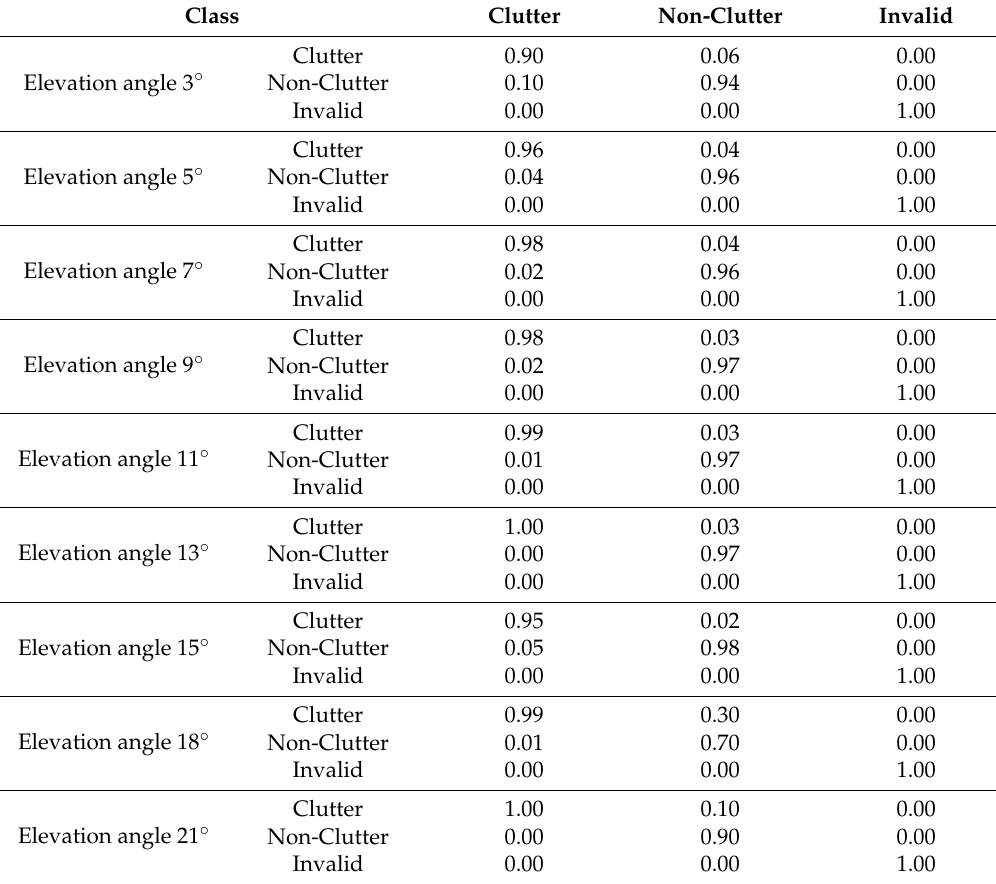
Table A3. Contingency table of clutter classification by NBC.